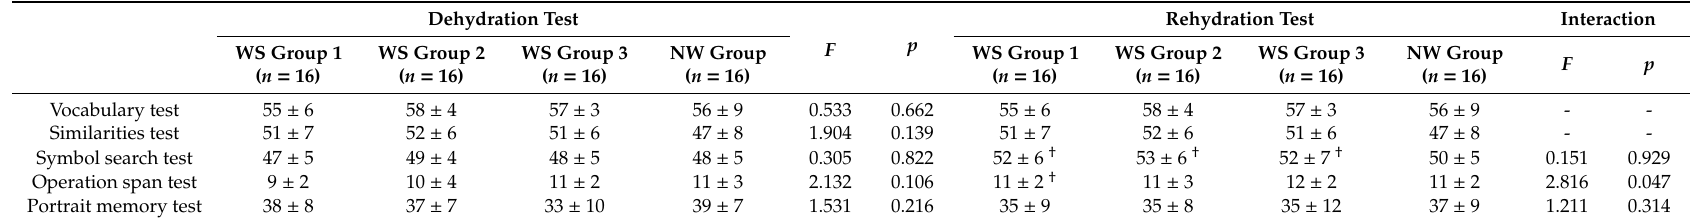
Table 4. Cognitive Performance of